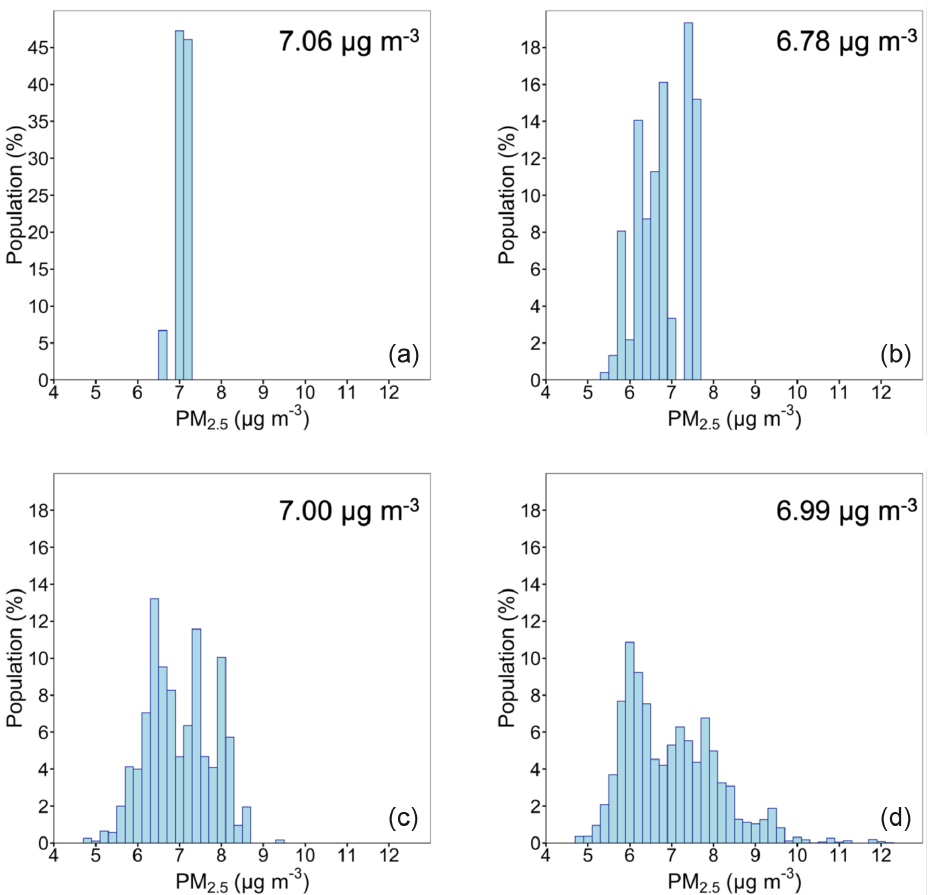
Figure 13. Population exposure histograms at (a) 36 × 36, (b) 12 × 12, (c) 4 × 4, and (d) 1 × 1km during July 2017. A different scale for population is used for the distribution at 36 × 36km resolution. The average population-weighted PM 2 . 5 concentration for each resolution is shown in the upper right corner of each window.